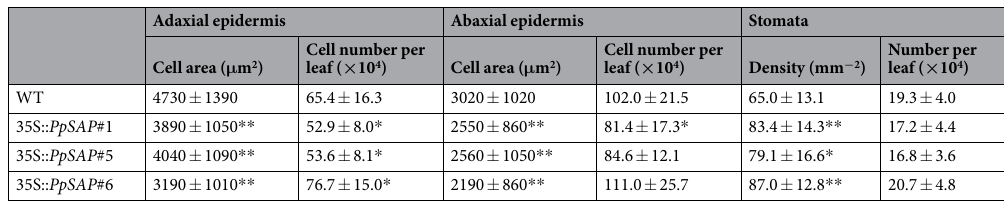
Table 1. Cell size and number in leaves of transgenic plum overexpressing PpSAP1 . The significant difference with respect to WT is labelled, with a confidence level of 95% ( * ) and 99% ( **